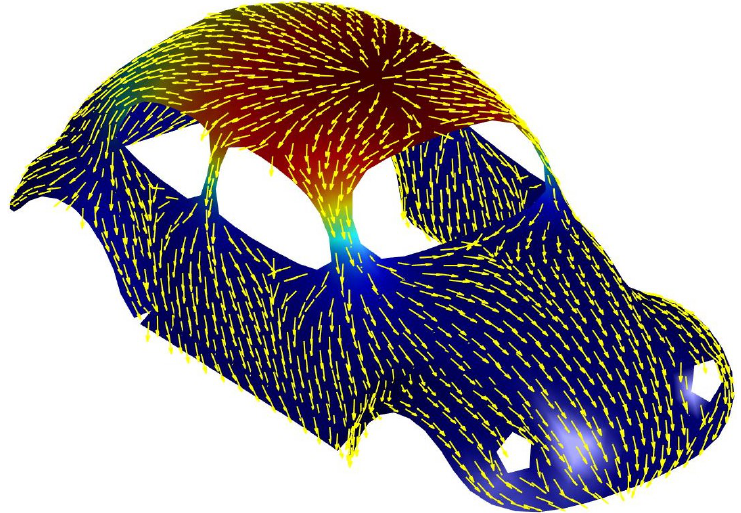
Figure 3. Normalized heat flux field (cid:126) H i ( x , t ) . The vector field is normalized and points in the direction of the geodesic paths from x i ∈ M